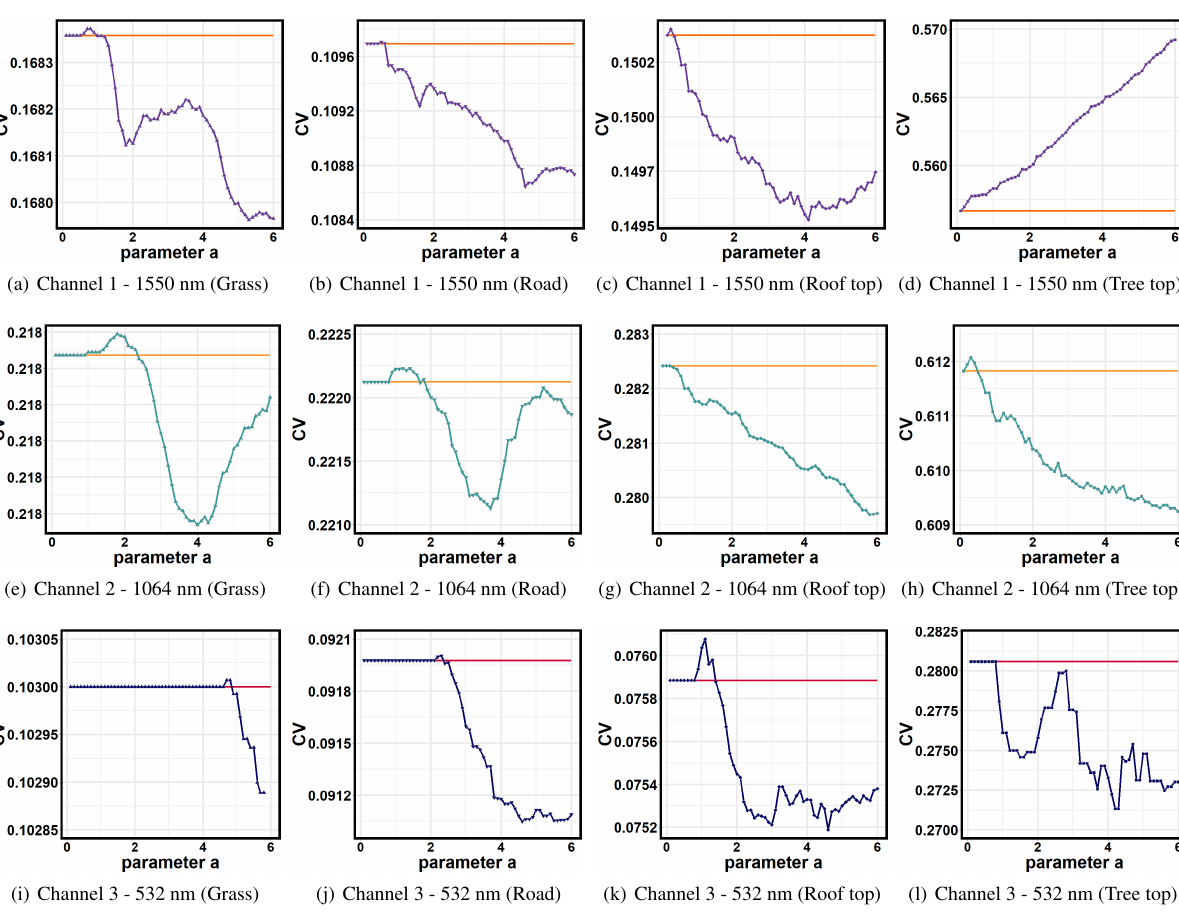
Figure 3. Results of range normalization on individual LiDAR data strip: cv against the parameter